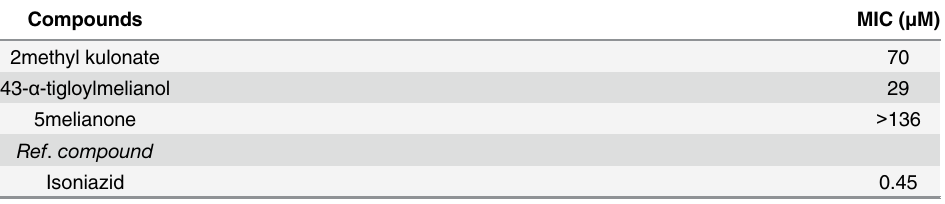
Table 3. Antimycobacterial activity (Minimum Inhibitory Concentration: MIC) of selected limonoids against Mycobacterium tuberculosis . Compounds MIC ( μ M) 2methyl kulonate 70 43- α -tigloylmelianol 29 5melianone > 136 Ref . compound Isoniazid 0.45 Data represent mean values of three independent determinations. The variation among them was less than 15% respect to the mean